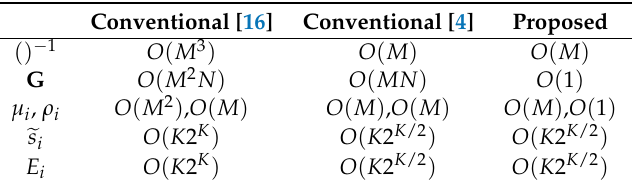
Table 2. Computational complexity